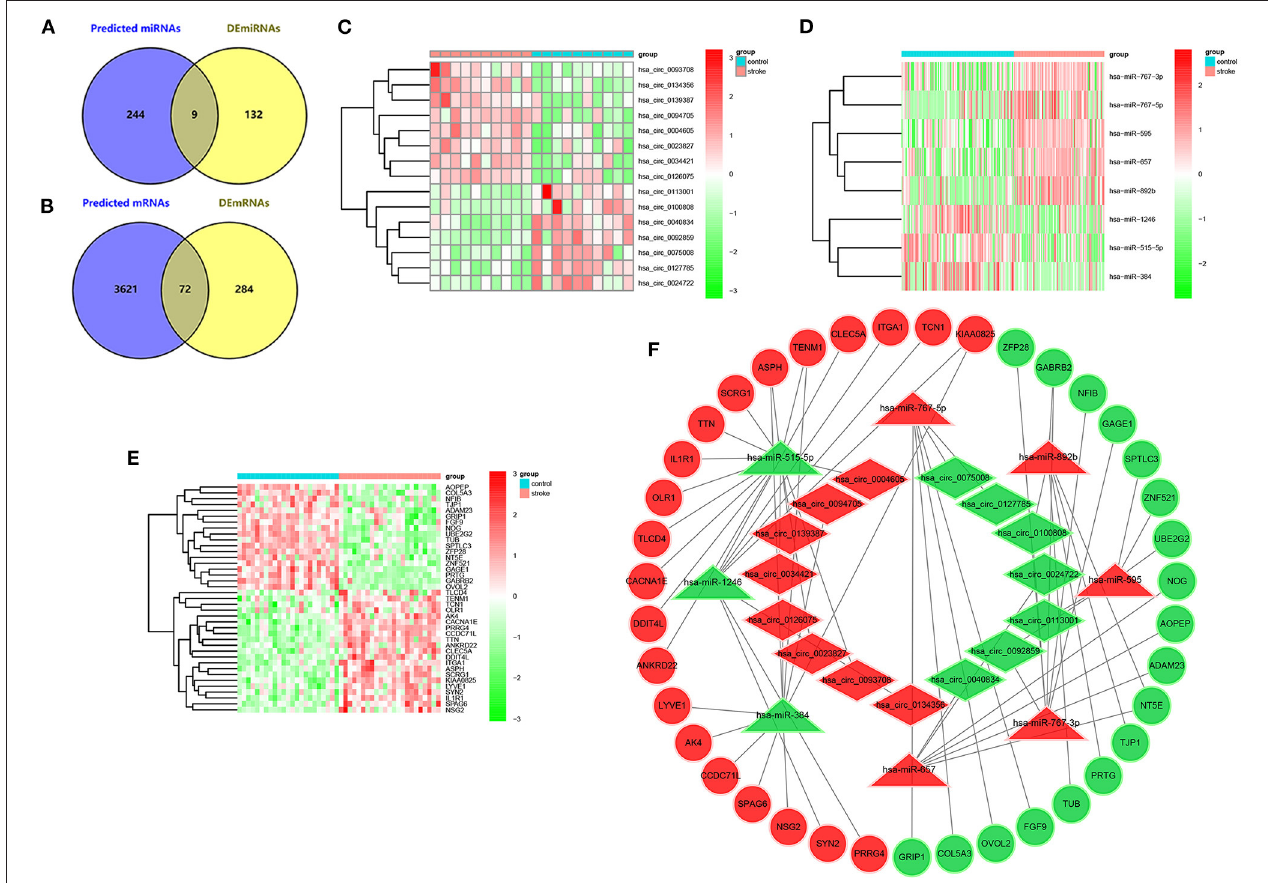
FIGURE 5 | Constrcution of ceRNA network in IS. (A) Venn diagram of intersecting miRNAs of predicted miRNAs and DEmiRNAs in the GSE117064 dataset. (B) Venn diagram of intersecting mRNAs of predicted mRNAs and DEmRNAs in the GSE58294 dataset. (C) Heatmap of 15 DEcircRNAs involved in the ceRNA network in the GSE195442 dataset. (D) Heatmap of 8 DEmiRNAs involved in the ceRNA network in the GSE117064 dataset. (E) Heatmap of 39 DEmRNAs involved in the ceRNA network in the GSE58294 dataset. (F) circRNA-miRNA-mRNA network in IS. The diamond, triangle and circle indicate circRNA, miRNA and mRNA respectively. Red represents expression up-regulation and green represents expression